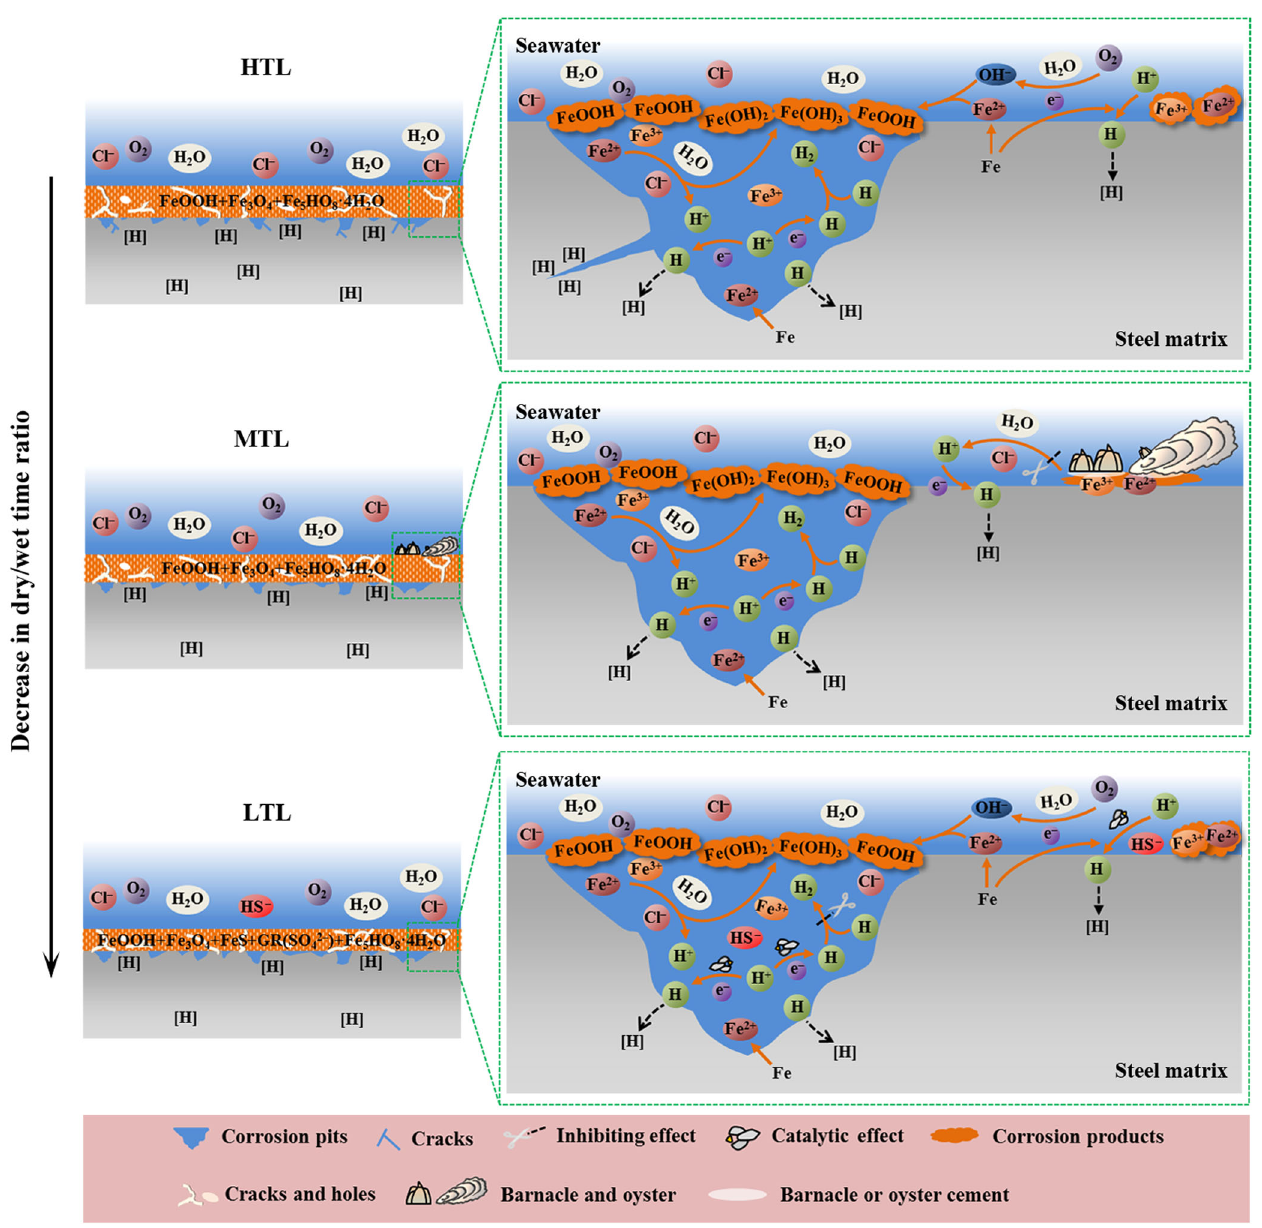
Fig. 13 Schematics of the corrosion, hydrogen permeation, and SCC behaviours of AISI 4135 steel at different locations in the tidal zone. The fi gure highlights the prominent roles of the corrosion pits, biofouling, and sul fi des in SCC of the AISI 4135 steel samples placed at the HTL, MTL, and LTL,